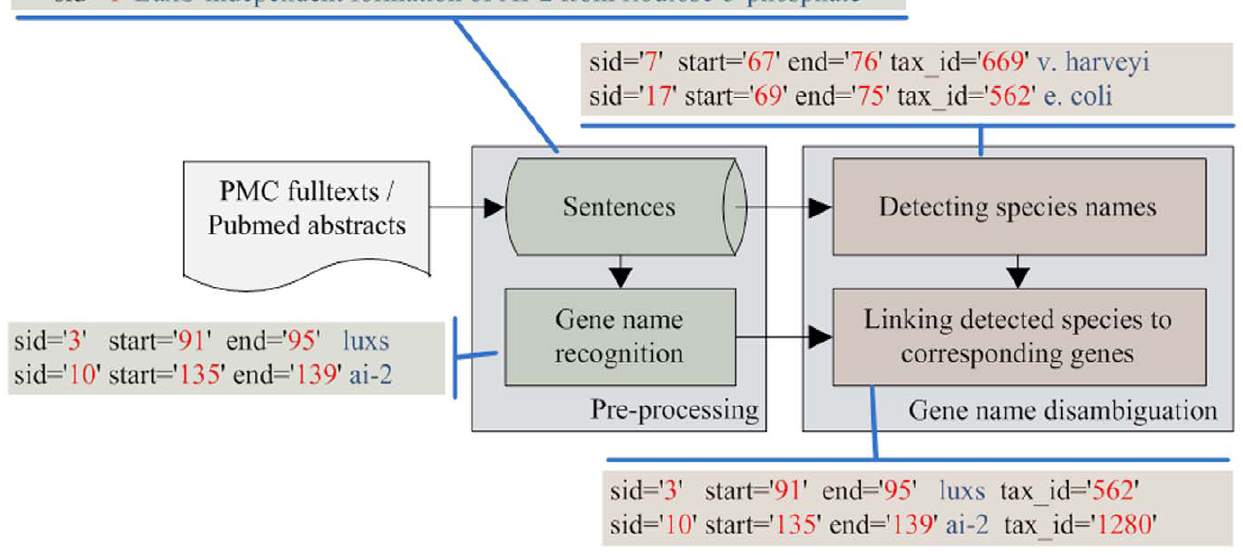
Figure 1. An overview of the SR4GN workflow. Sid, start, end and tax_id in shaded boxes refer to individual sentence identifier; beginning and end text span of a gene or species mention; and NCBI Taxonomy ID.